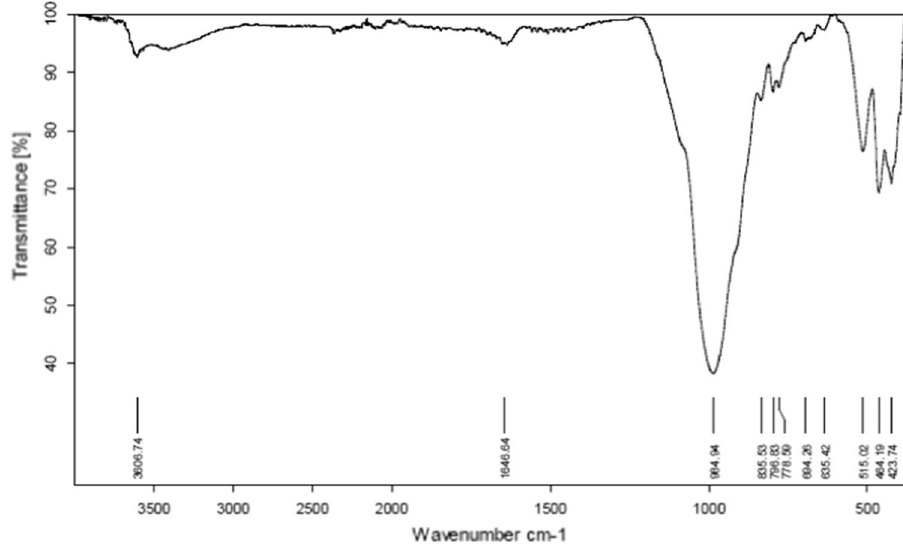
Kenadsa’s natural green clay